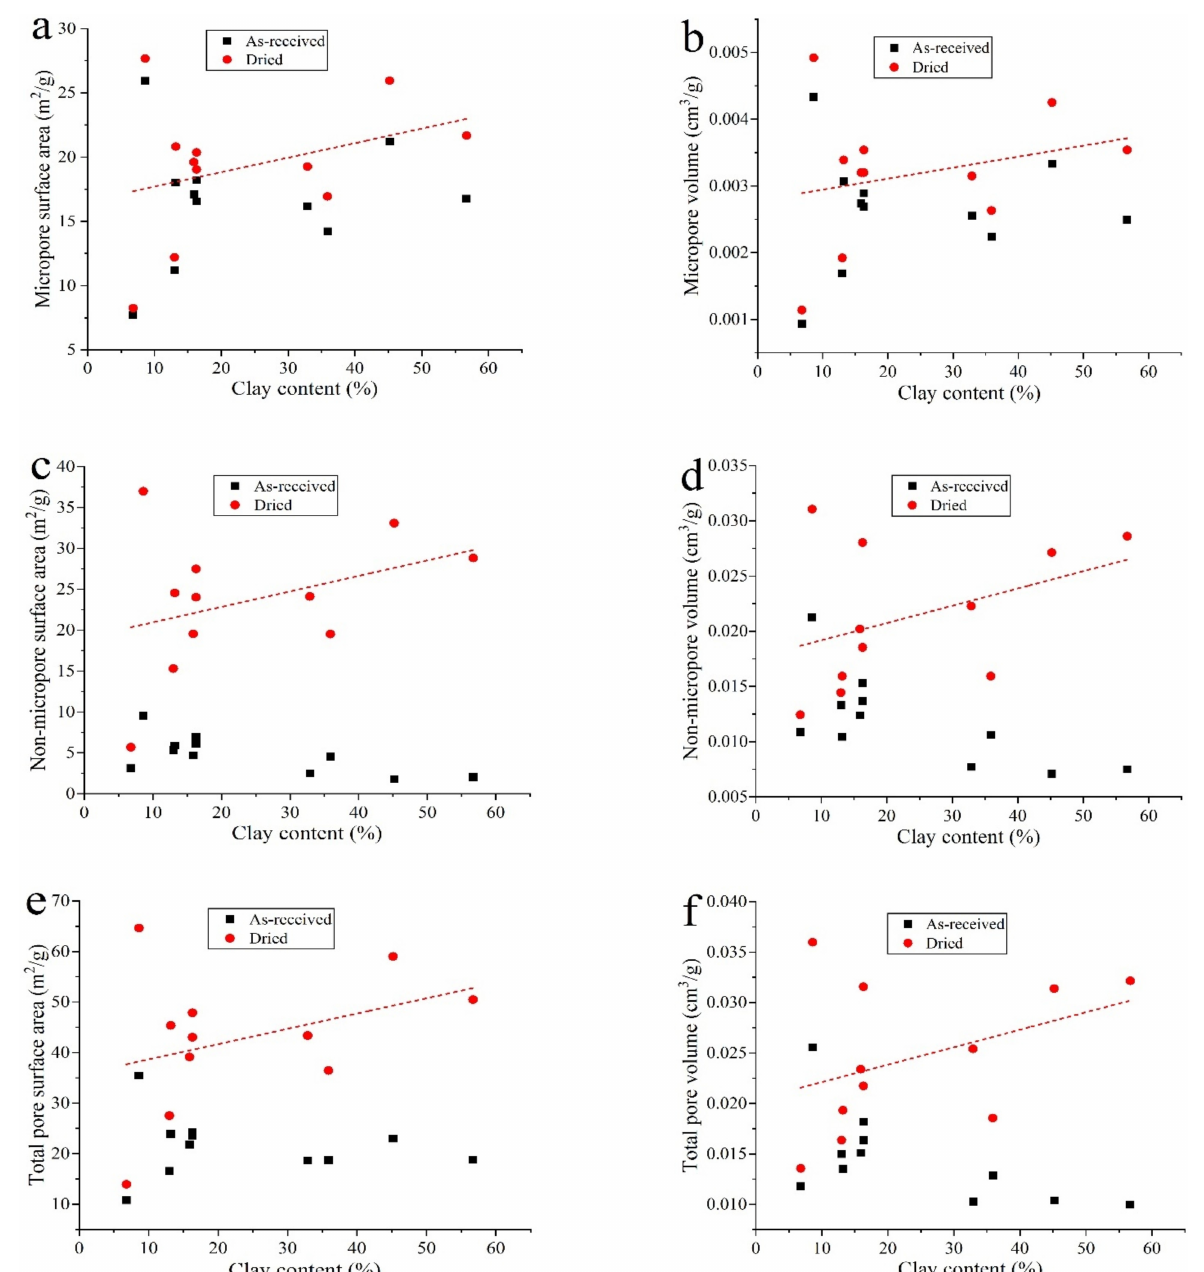
Figure 7. Correlations of pore surface area ( a , c , e ) and volume ( b , d , f ) with clay content of the deep shale samples in the Luzhou